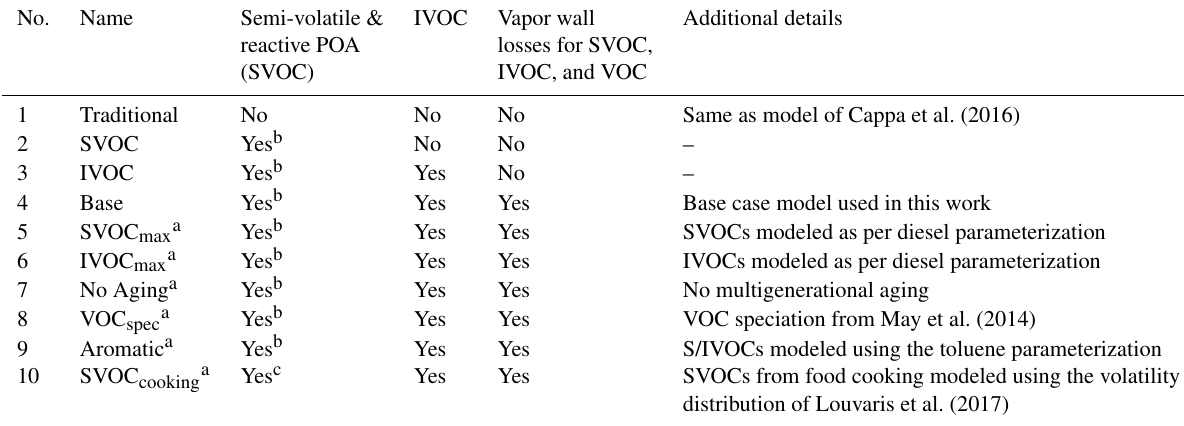
Table 3. Names and descriptions of the simulations performed in this work.